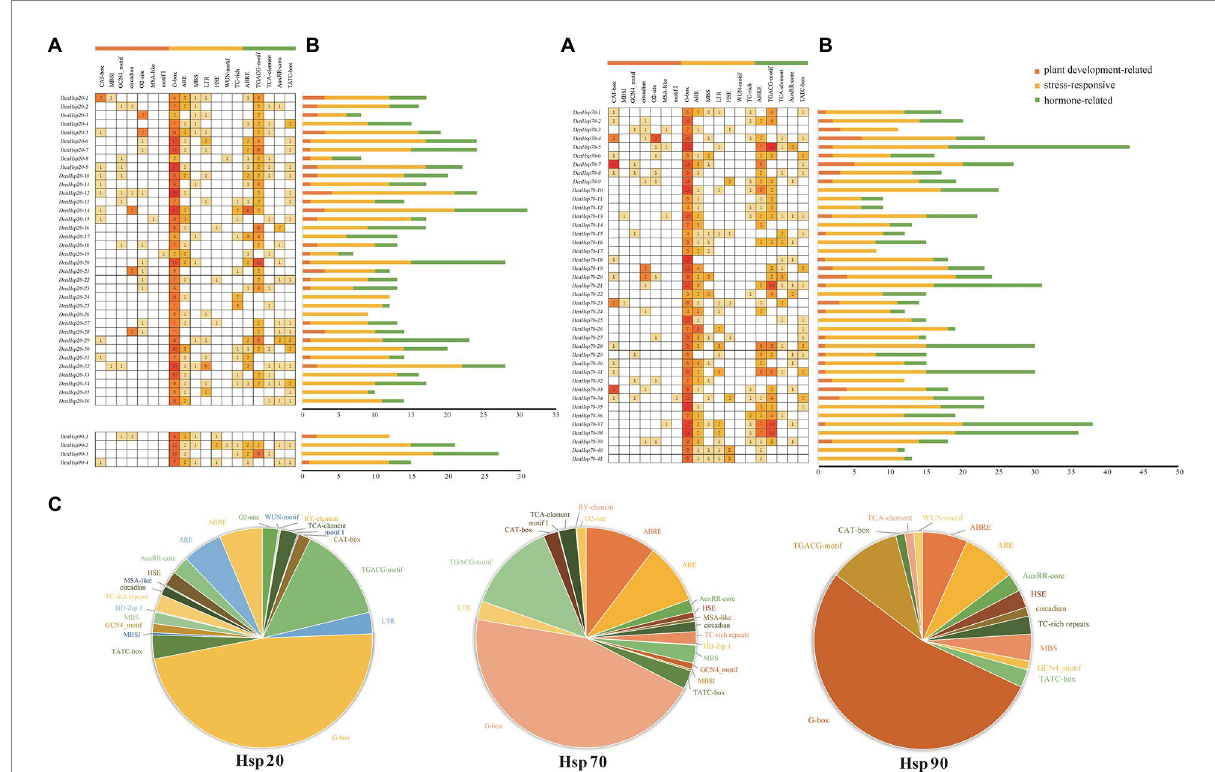
FIGURE 6 Information of cis -acting elements in Hsp20 , Hsp70 and Hsp90 genes of Dendrobium officinale . (A) The gradient orange colors and numbers in the grid indicate the number of different cis -elements. (B) The different colors histogram indicates the number of cis -elements in each category. (C) The ratio of different cis -acting elements in Hsp20 , Hsp70 and Hsp90 genes is shown as pie